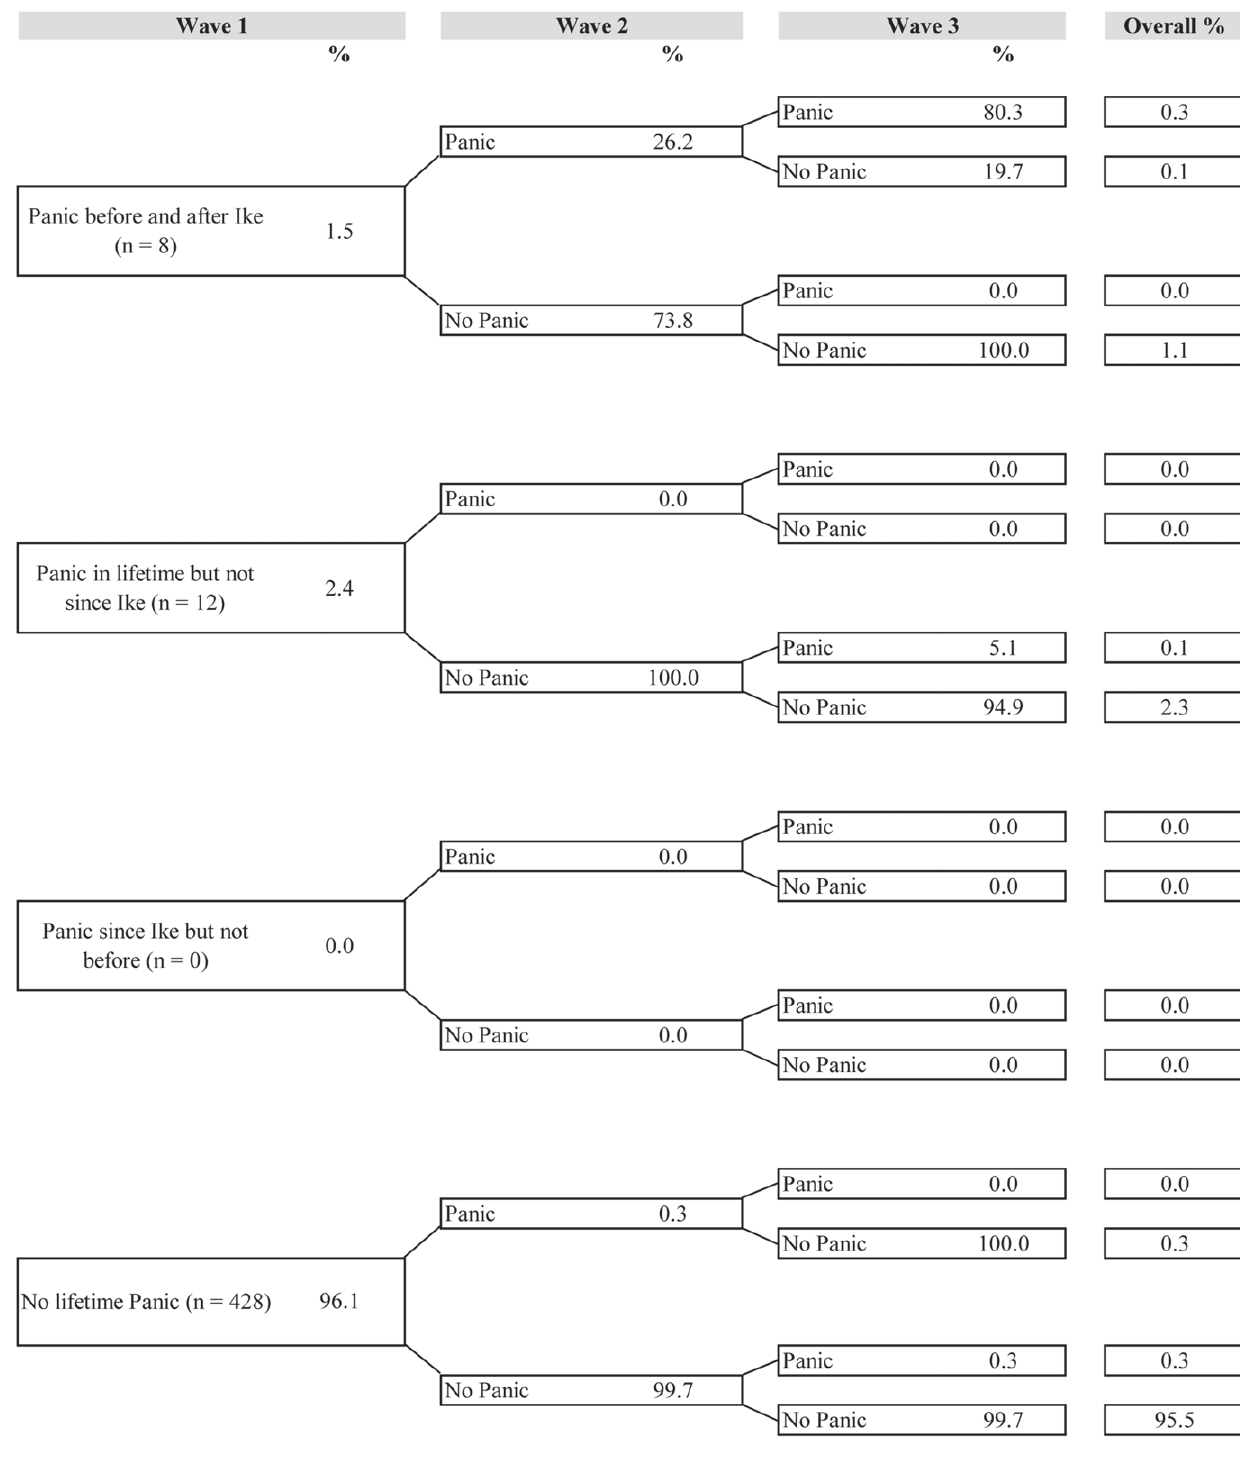
Figure 3. Trajectories of panic disorder (n=448).